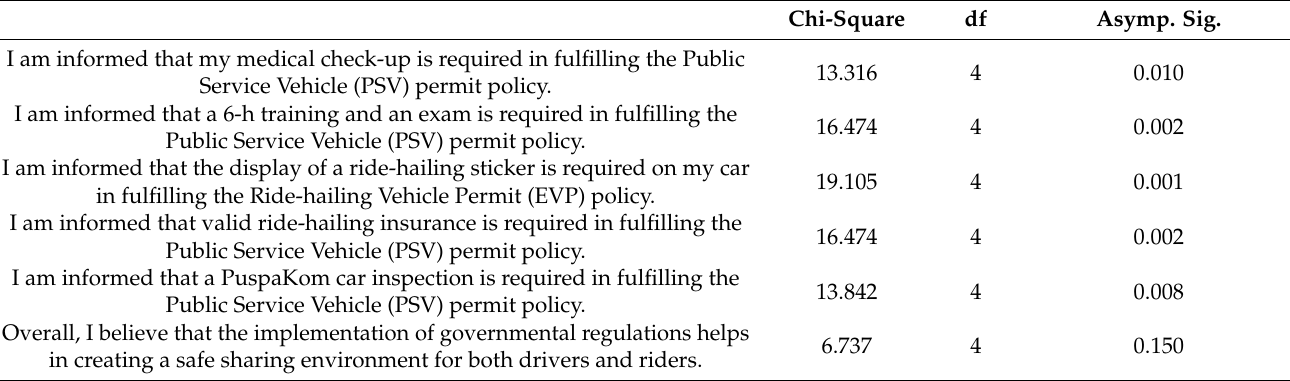
Table A5. Test Statistics for Goodness-of-Fit (Chi-Square Test). Chi-Square df Asymp.